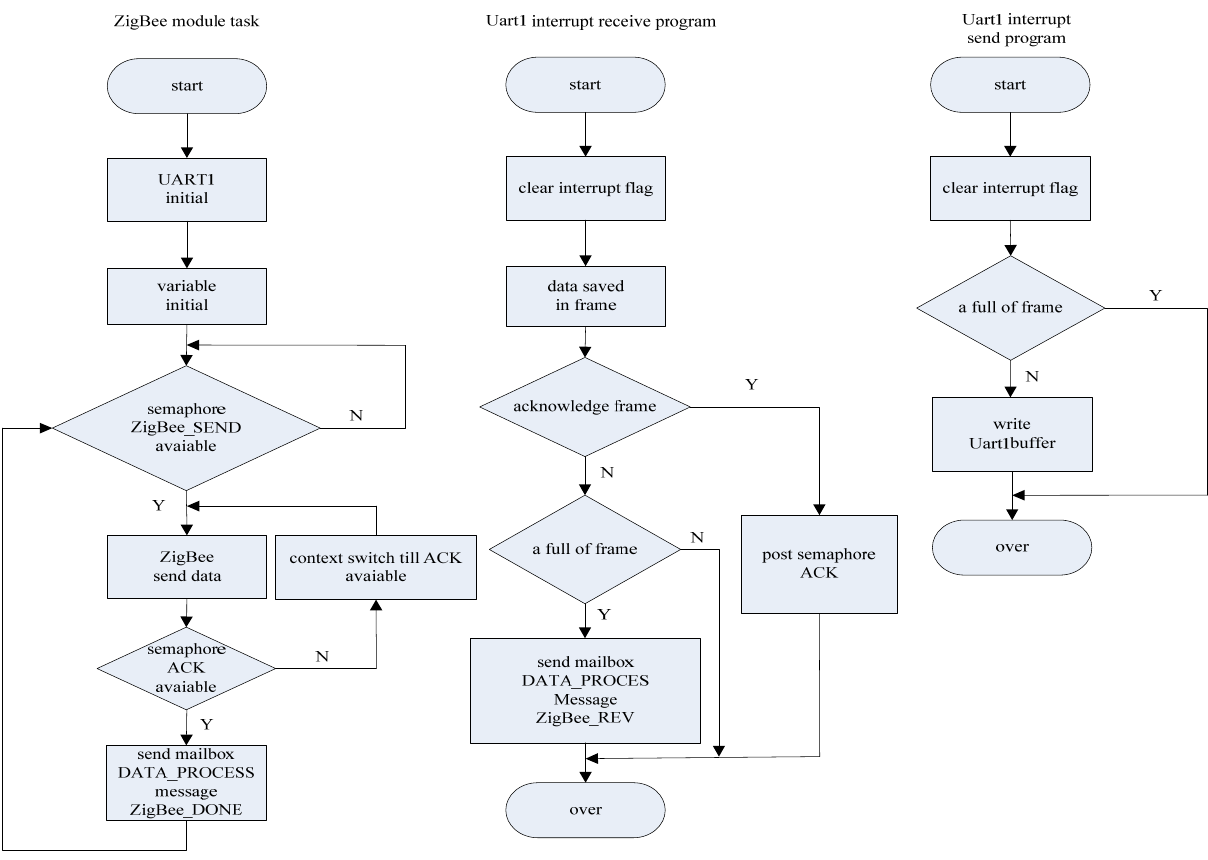
Figure 19. The flow chart of ZigBee module communication task and the corresponding serial interrupt service